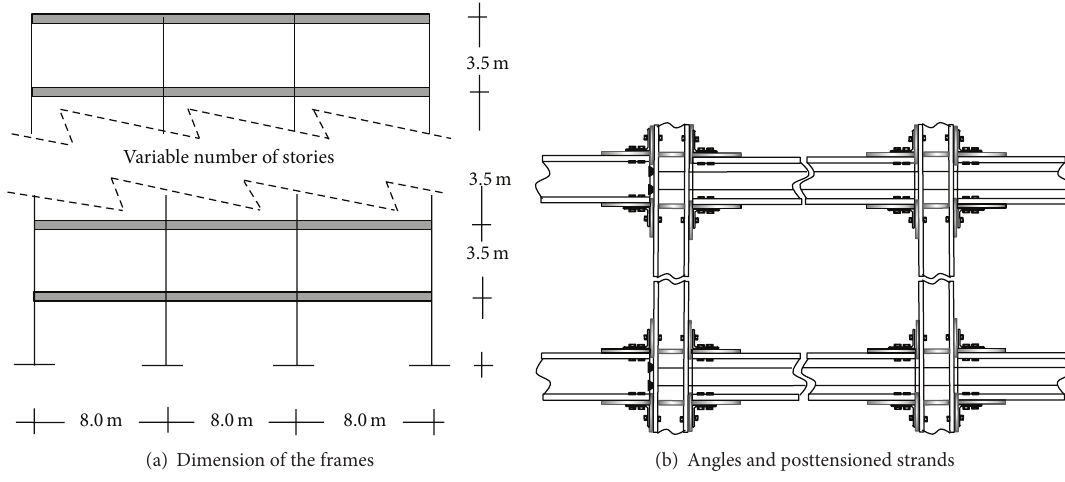
Figure 3: Geometrical characteristics of the frames with PTED